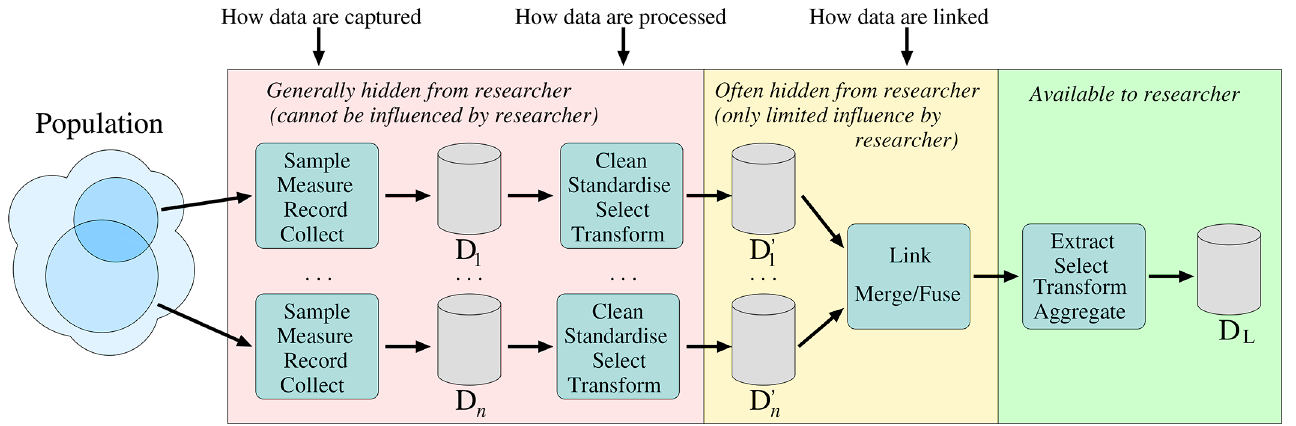
Figure 2: The general pathway of population data from their source to a researcher’s